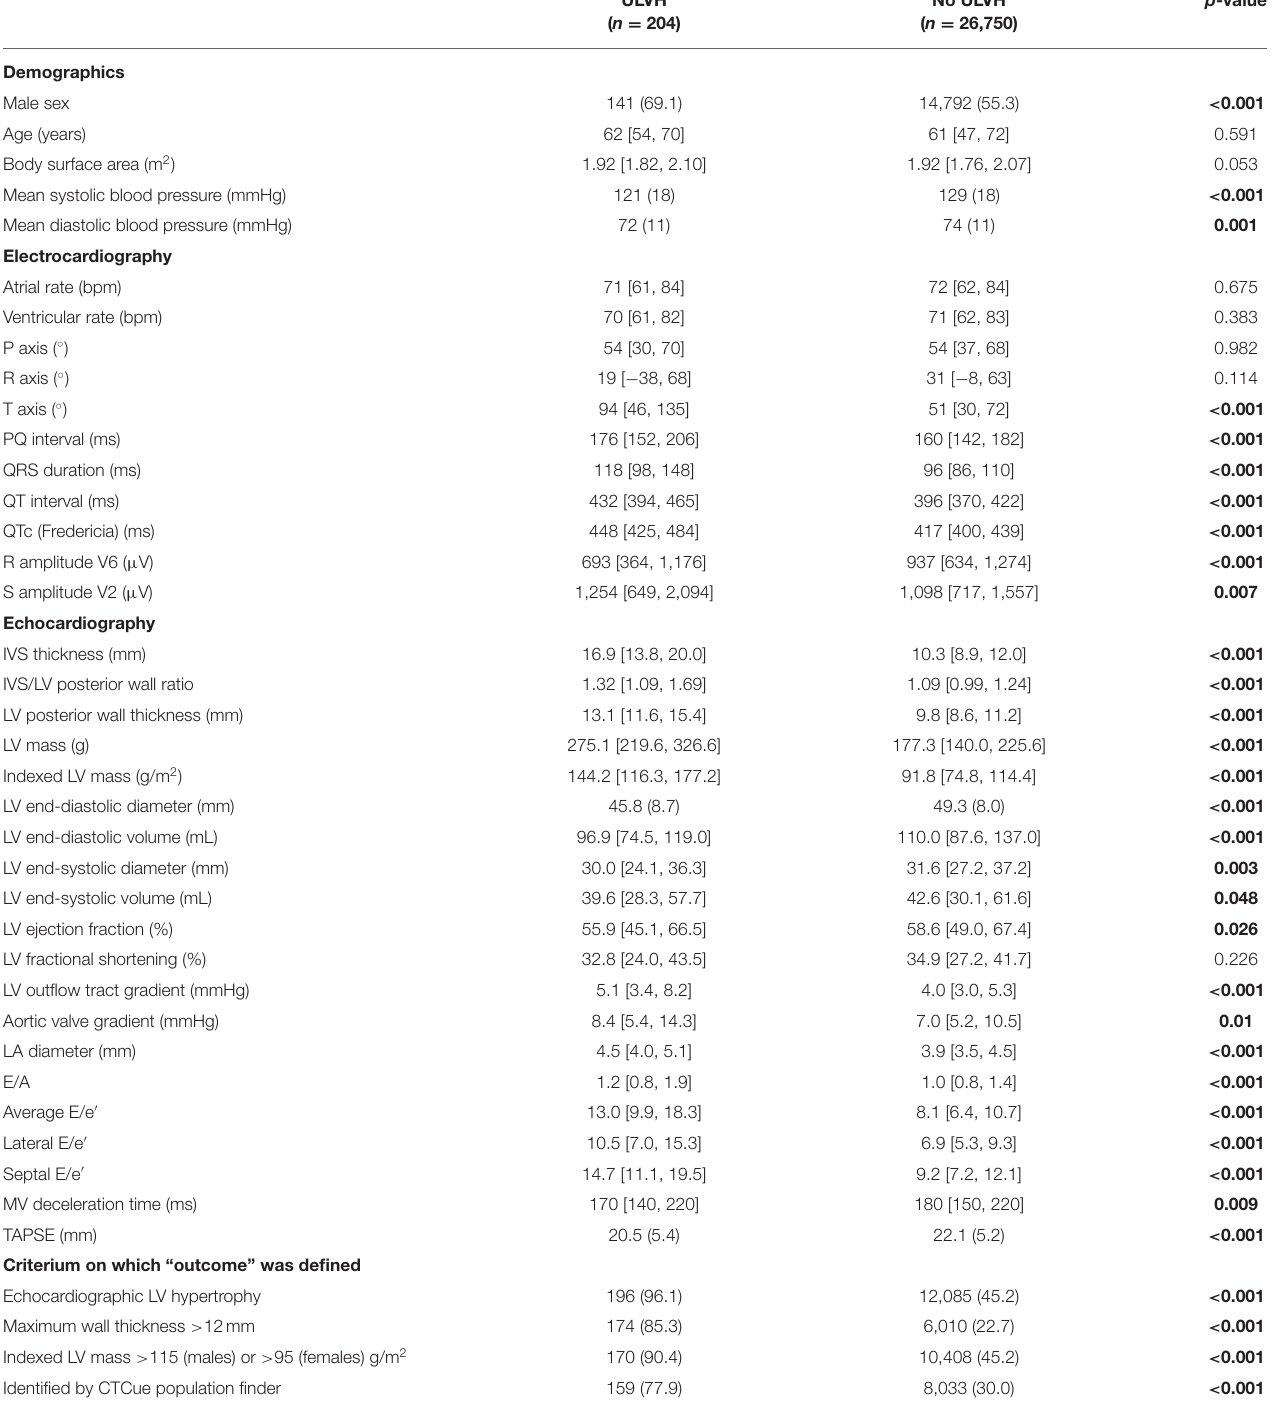
TABLE 1 | Patient